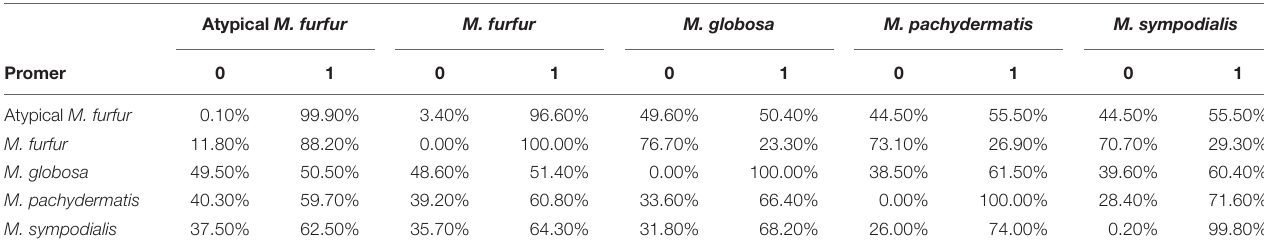
TABLE 3 | Percentage of the genome with zero (0), or one or more (1) matches in the Promer genome alignment (Delcher et al., 2002) with a maximum gap between two adjacent matches in a cluster of 30 amino acids and a minimum length of a maximal exact match of six amino acids. Atypical M.